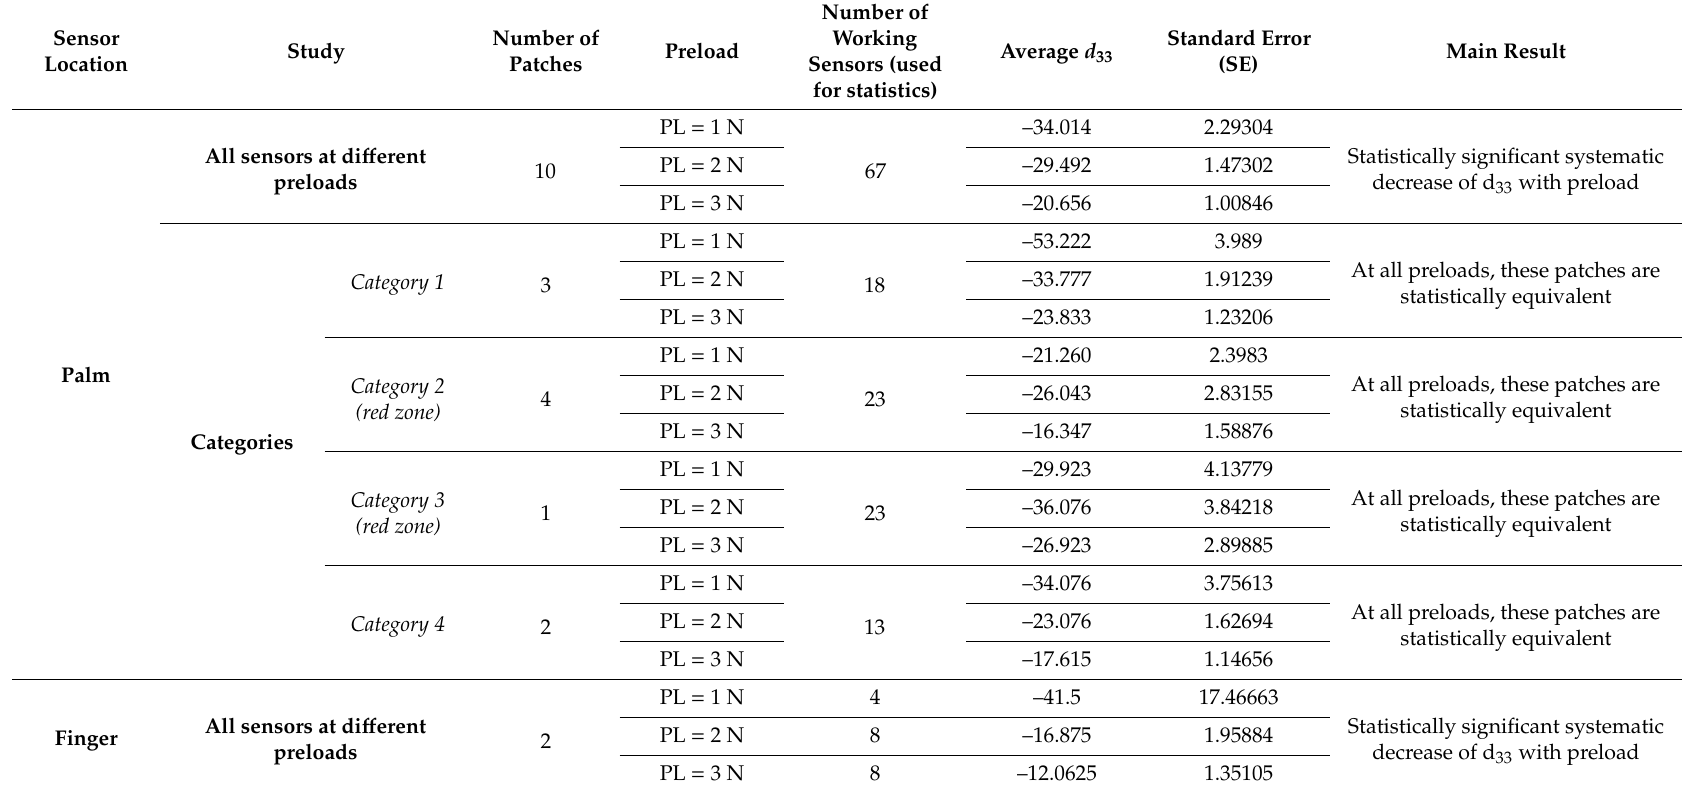
Table 2. Summary of